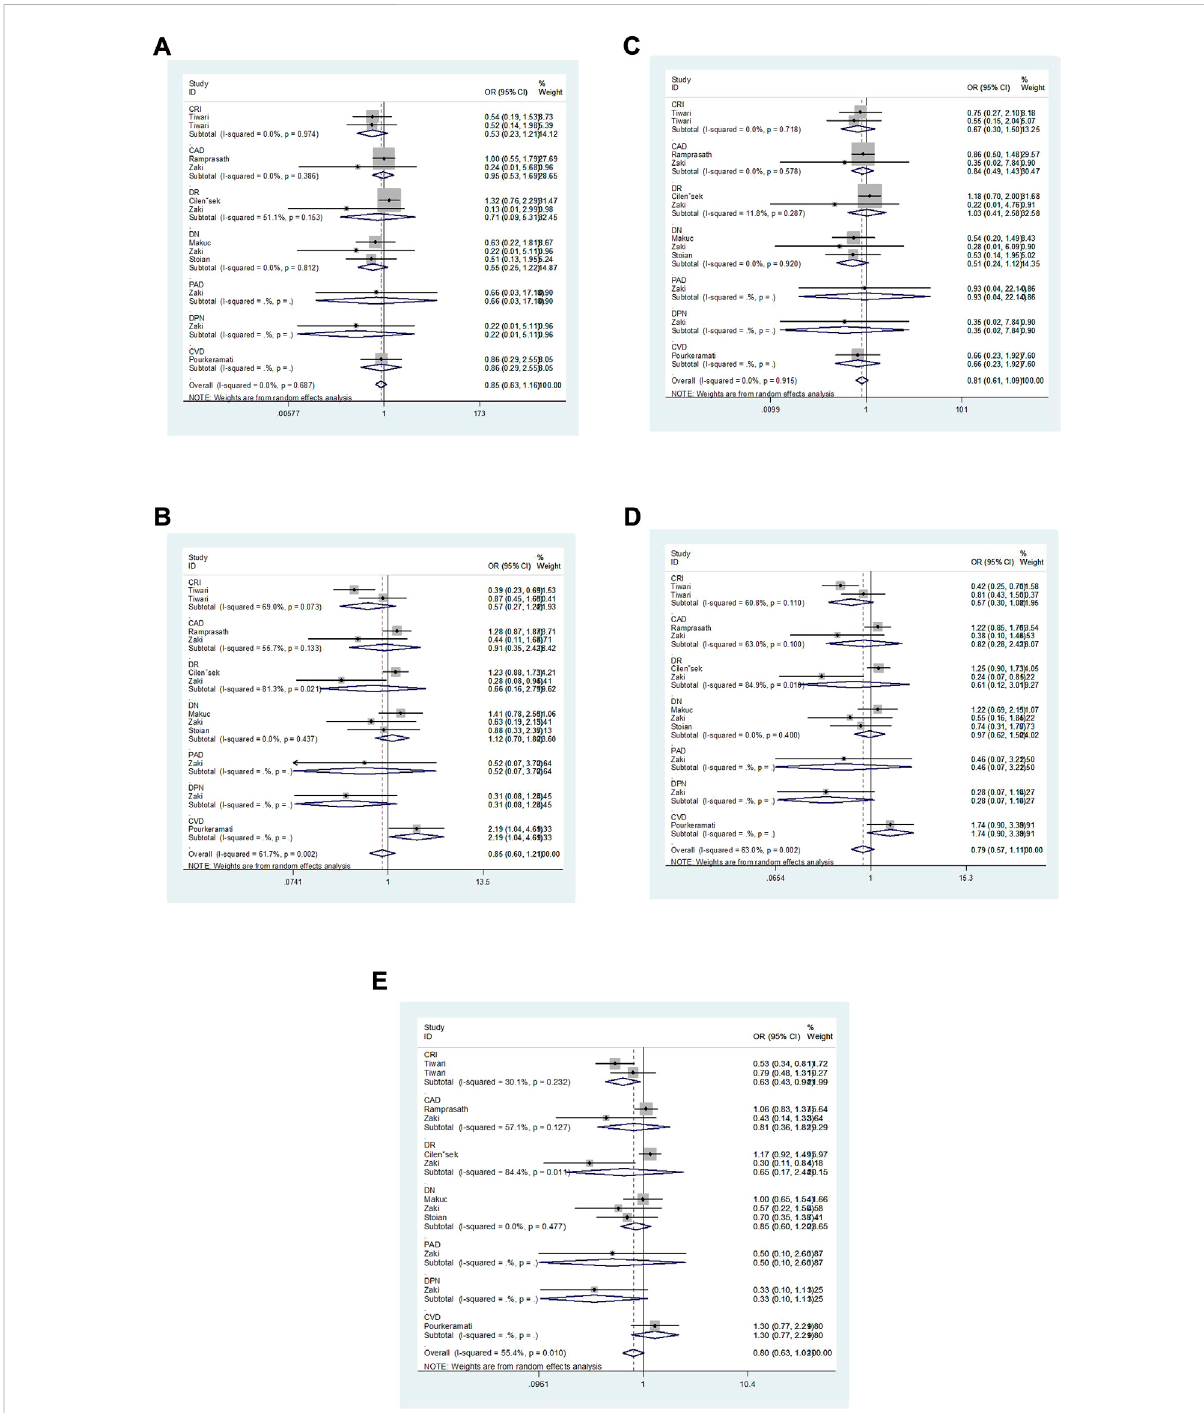
FIGURE 4 ForestplotoftheassociationbetweenGSTPIpolymorphismandT2DMcomplicationsrisk[ (A) :VVvs.II; (B) :IVvs.II; (C) :VVvs.IV+II; (D) :VV+IV vs. II; (E) : V vs.